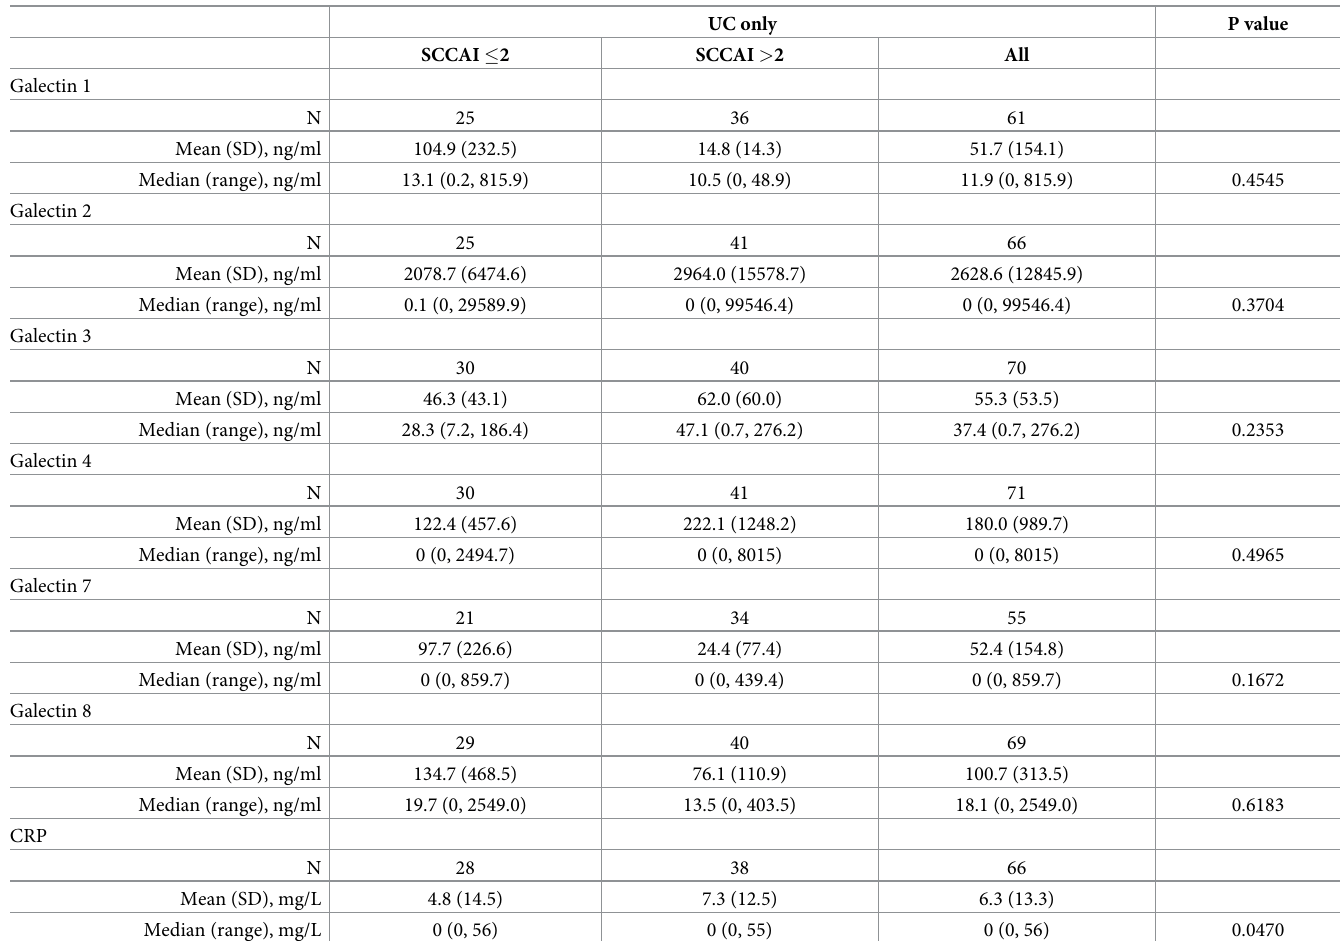
Table 3. Galectin levels in patients with active and inactive